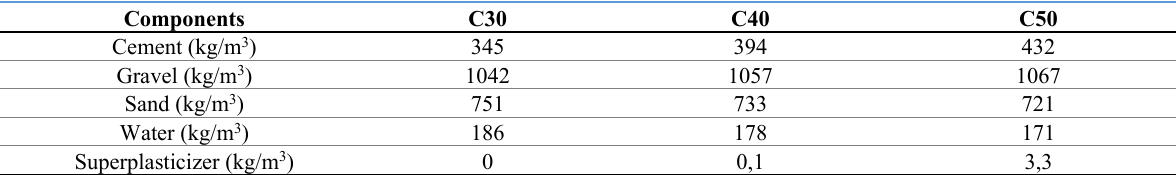
Table 2. Mix design formulations for the concrete columns Components C30 C40 C50 Cement (kg/m 3 ) 345 394 432 Gravel (kg/m 3 ) 1042 1057 1067 Sand (kg/m 3 ) 751 733 721 Water (kg/m 3 ) 186 178 171 Superplasticizer (kg/m 3 ) 0 0,1